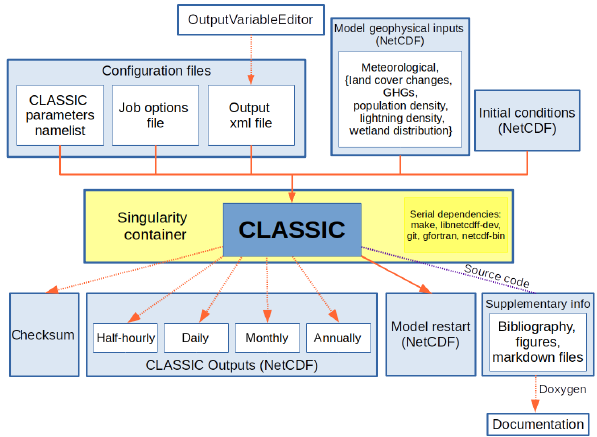
Figure 2. CLASSIC model workflow. For each CLASSIC simula- tion, the solid lines indicate mandatory model inputs or outputs. The OutputVariablesEditor can be used to edit the XML file that controls the model outputs and specifies their metadata (Sect. 3.2.8). Model parameters are read in from the CLASSIC parameters’ namelist file, while the simulation options such as location of input files and model configuration options are read in from the CLASSIC job op- tions file. The required model geophysical inputs vary depending on the model configuration chosen but meteorological inputs are al- ways required. All model outputs can be switched on or off depend- ing on the simulation except the model restart file. Checksums can be used to ensure changes to the model do not impact model per- formance (see Sect. 3.2.2). The CLASSIC source code is combined with other supplementary information by Doxygen to produce the model documentation (see Sect.